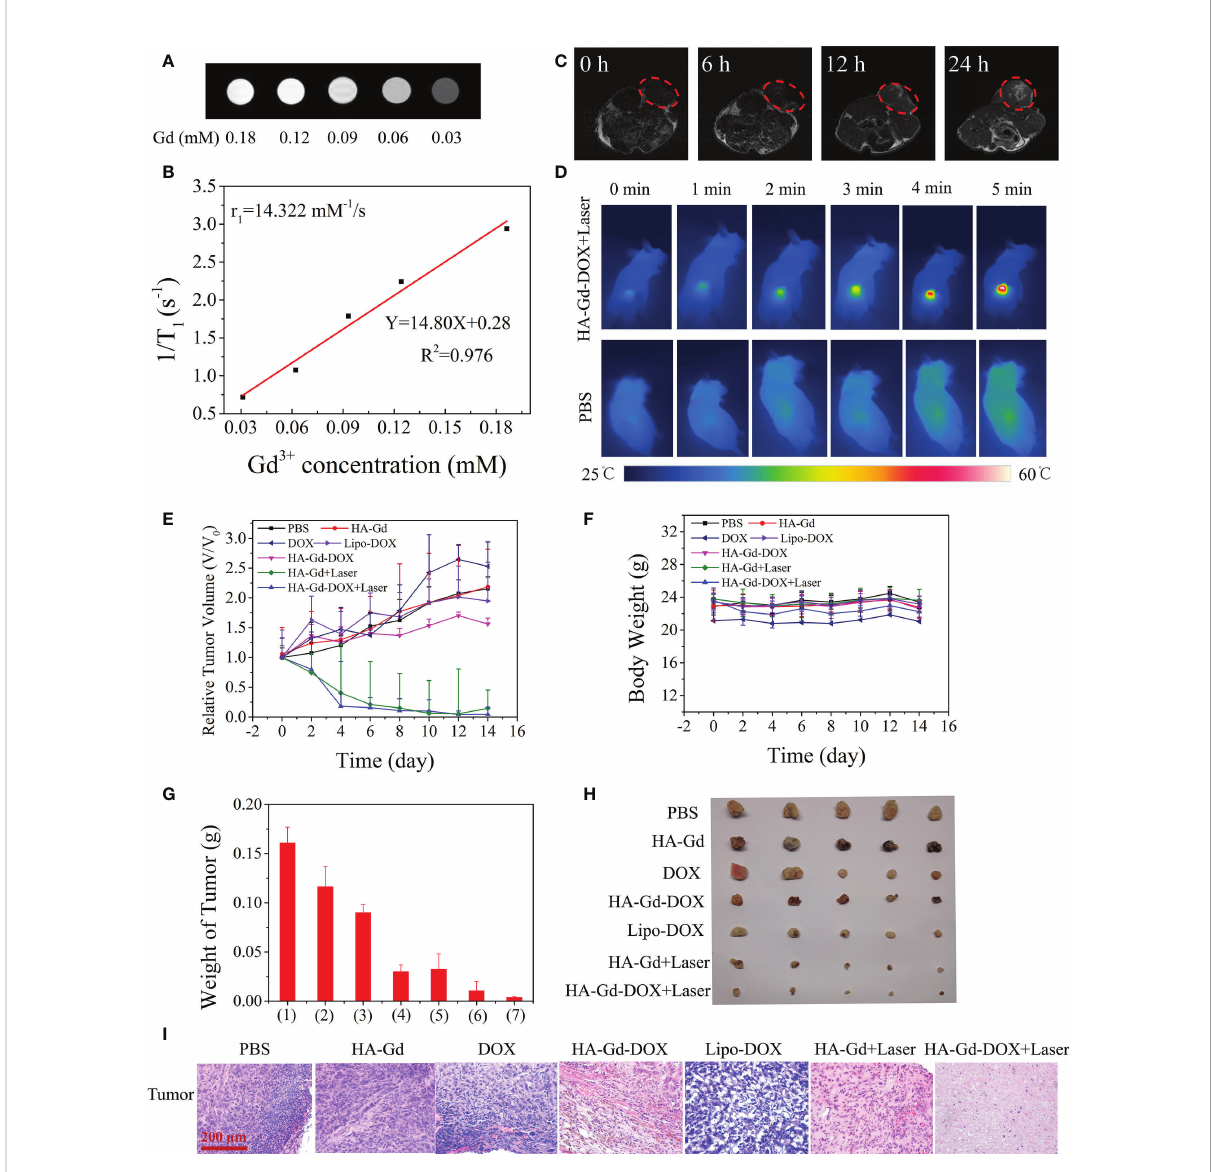
FIGURE 5 (A) T 1 -weighted MR images. (B) T 1 relaxation rates (r 1 ) of HA-Gd-DOX at different concentrations. (C) In vivo T 1 -weighted MR images of a tumor-bearing mouse after injection 0, 6, 12, and 24 h of HA-Gd-DOX (15 mg/kg). (D) Infrared thermal images of tumor-bearing mice treated with PBS and HA-Gd-DOX under irradiation with an 808-nm laser at different time periods. (E) Tumor volume variation curves and (F) body weight variation curves of tumor-bearing mice treated with different treatments. Data are expressed as mean ± SD ( n = 5). (G) The weights of excised tumors after 14 days of various treatments: (1) PBS; (2) HA-Gd; (3) DOX; (4) HA-Gd-DOX; (5) Lipo-DOX; (6) HA-Gd+Laser; and (7) HA- Gd-DOX+Laser. (H) Digital photographs of the excised tumors 14 days after treatment from fi ve mice in each group. (I) H&E staining images of the tumors collected 14 days after various